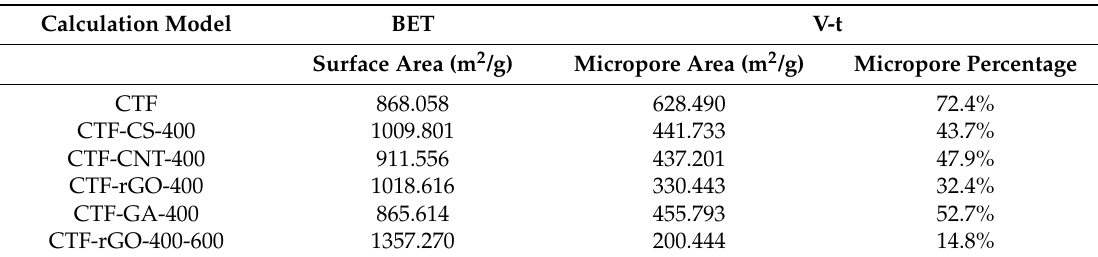
Table 1. Summary and analysis of nitrogen sorption data for all synthesized CTF composites. BET: